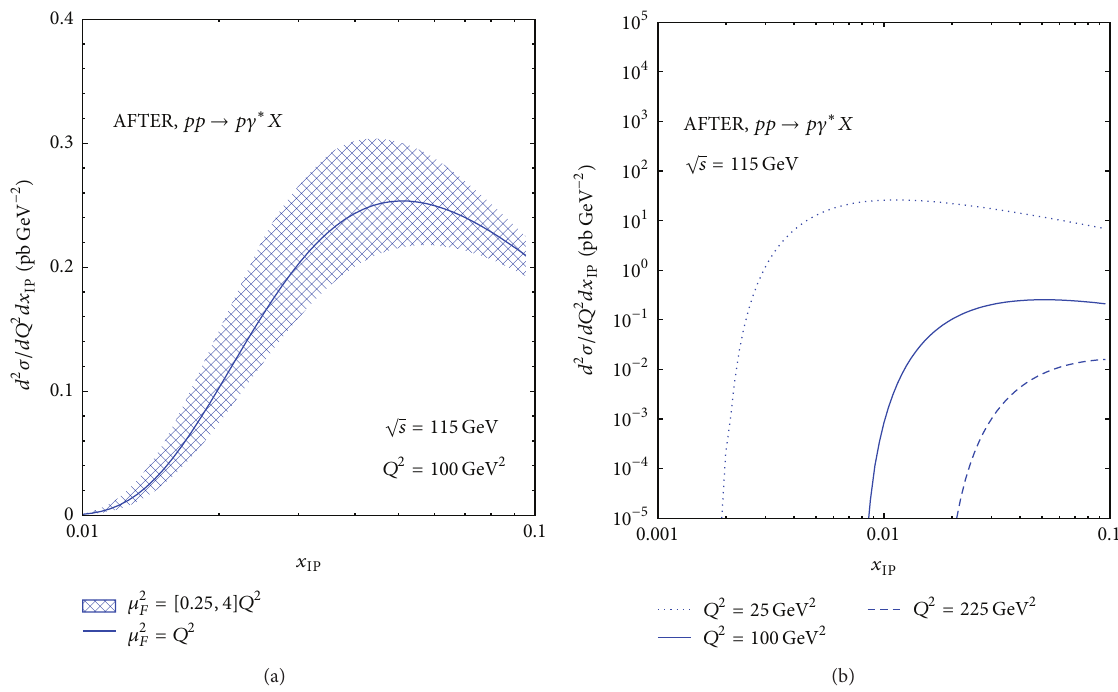
Figure 4: (a) Double differential cross sections for the production of a Drell-Yan pair of mass 𝑄 2 = 100 GeV 2 . Blue error bands represent theoretical errors estimation, as described in the text. (b) Double differential cross sections for three different invariant